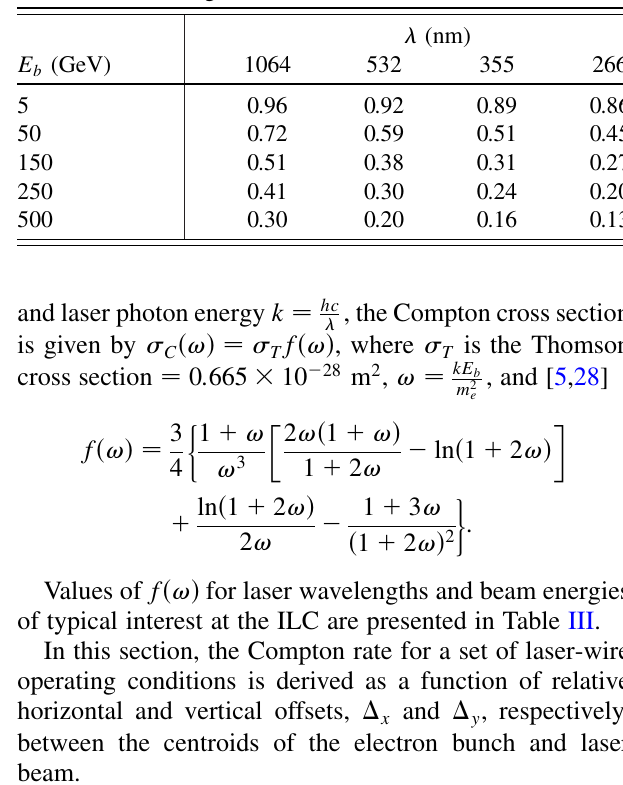
TABLE III. Values of f (cid:6) ! (cid:7) for various laser wavelengths (cid:13) and ILC beam energies.